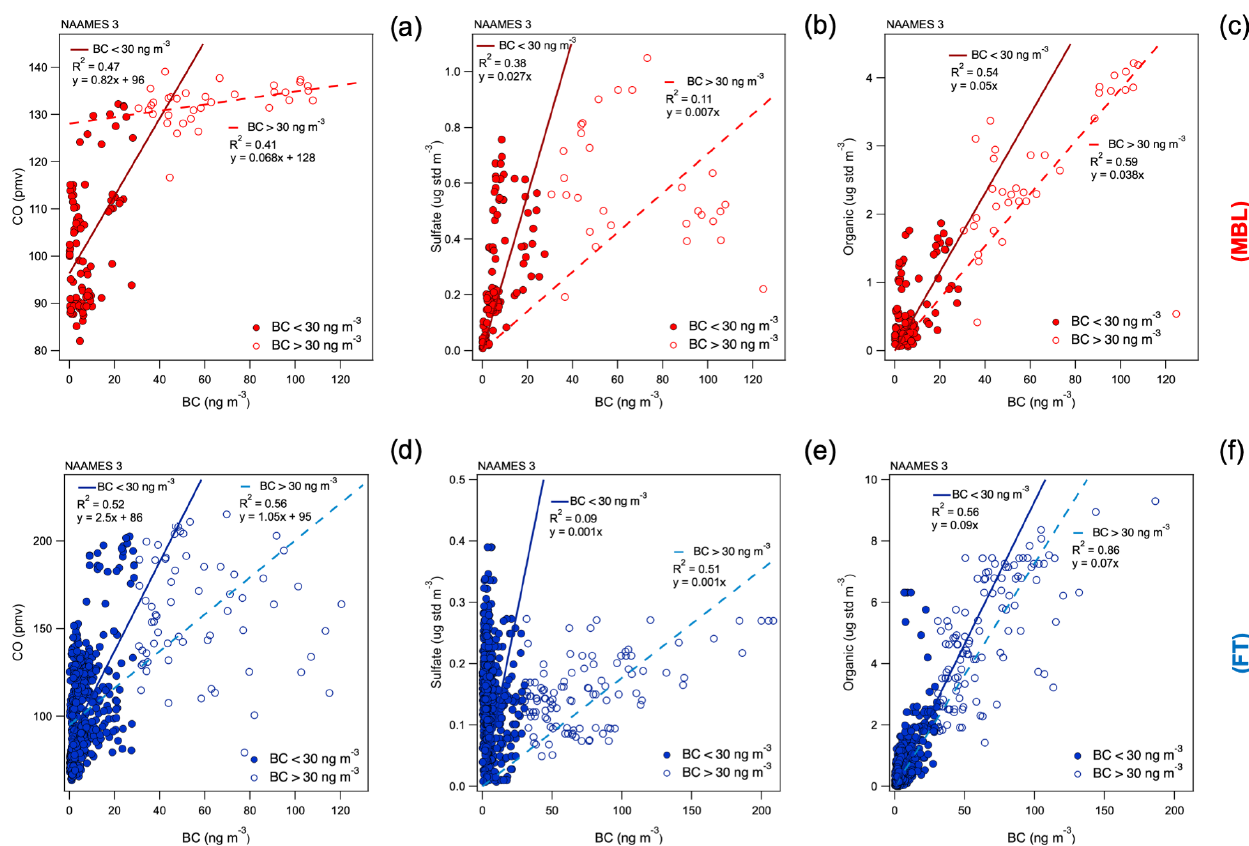
Figure 9. Correlation between BC and CO (a, d) , BC and sulfate (b, e) , and BC and organics (c, f) in the MBL (red) and FT (blue) during